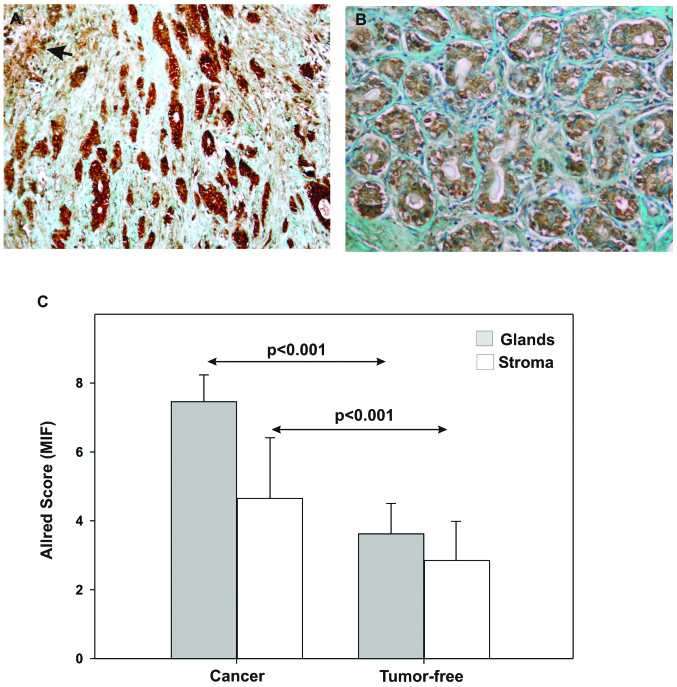
Immunohistochemical detection of MIF in non-cancerous breast (B) and breast cancer tissue sections with a strong positivity in the peritumoral fibroblasts (arrow) (A). Semi-quantitative analysis (Allred score) of MIF expression in glandular and stromal compartments (C) (Mann-Whitney test, p<0.001).